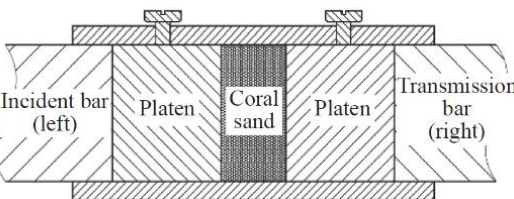
Figure 17. SHPB experiment section for coral sand specimen (reprinted from Ref. [82]).